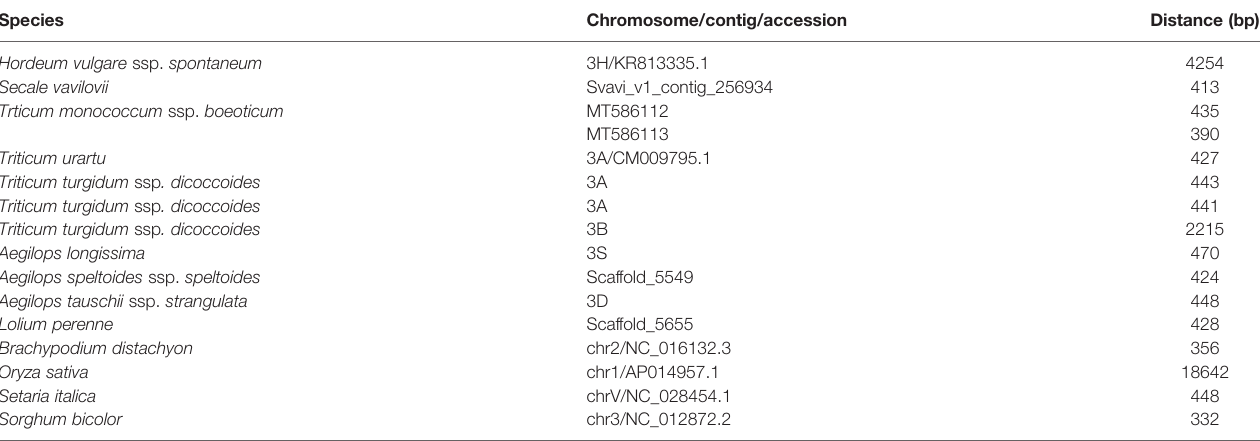
TABLE 2 | Separation between Poaceae Btr1-like and Btr2-like